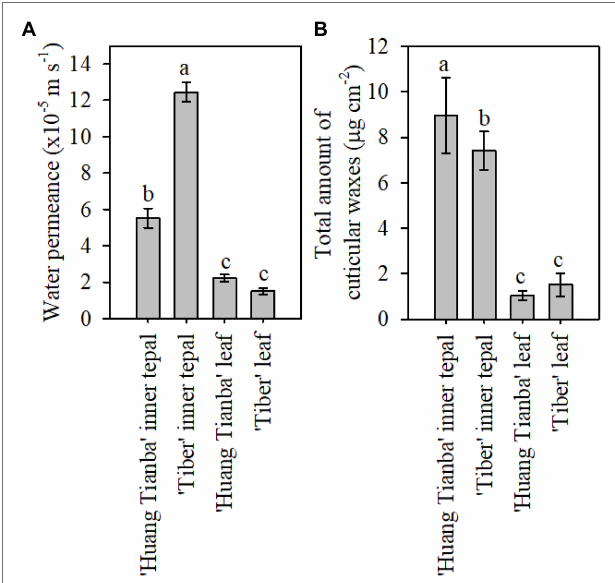
FIGURE 3 | Cuticular transpiration rate and wax coverage of leaves and tepals of lily flowers at the open stage. (A) Minimum water conductance, and (B) total amount of cuticular waxes on inner tepals and intact leaves of the Lilium cultivars ‘Huang Tianba’ and ‘Tiber’. Data are presented as the mean ± standard deviation ( n = 12 for transpiration, n = 5 for cuticular wax). The different lowercase letters on the bars indicate significant differences ( p <